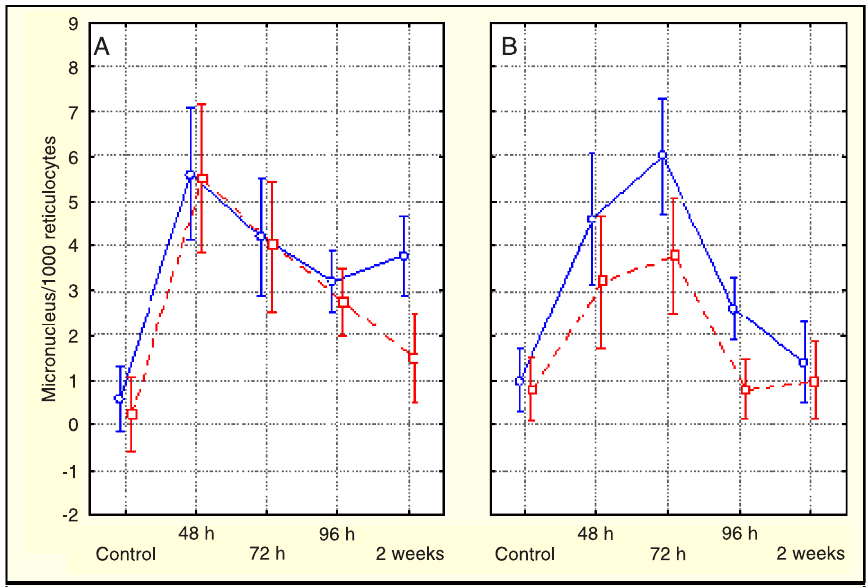
Figure 4. Micronucleus (MN) frequency in A , 3- and B , 12-week-old male (blue full line) and female (red dashed line) mice exposed to 5 µg/kg diethylstilbestrol. For each dose, age and sex, 5 animals were analyzed. Micronucleus frequency is presented per 1000 reticulocytes. Vertical bars indicate 95% confidence intervals. ANOVA for repeated measurements was used to compare responses at each sampling time.